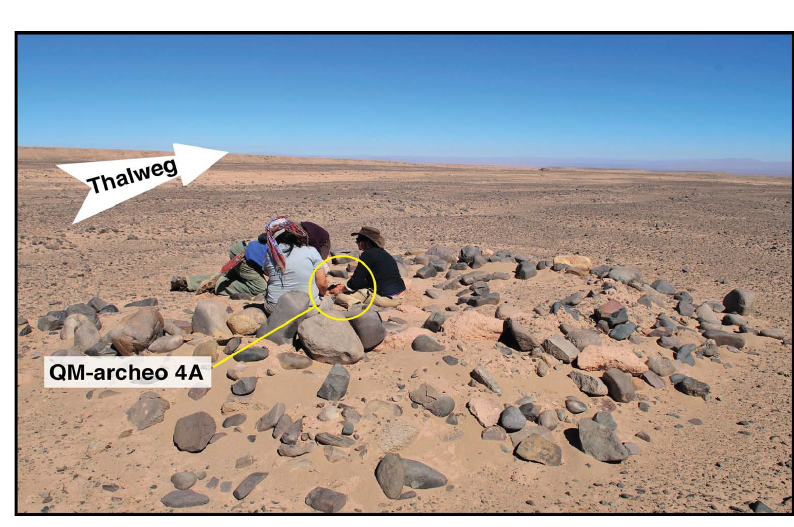
Fig. A5. Collapsed semi-circular structure from which superficial and subsurface charcoal samples were recovered.